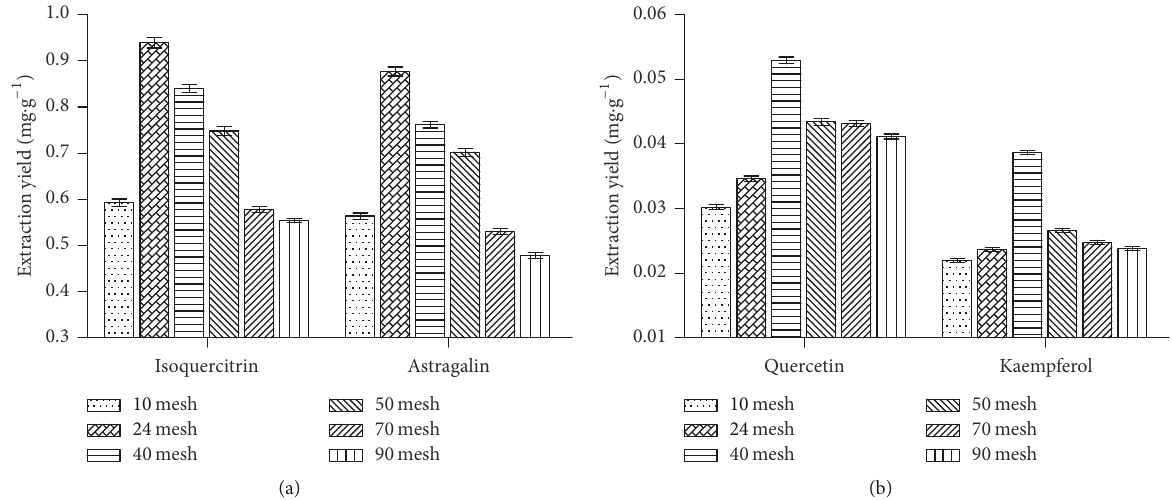
Figure 5: Effect of the particle size on extraction yields. Type of IL: [BMIM]BF 4 ; concentration: 0.5 mol ⋅ L −1 ; solid-liquid ratio: 1: 10g ⋅ mL −1 ; ultrasound time: 30 min; ultrasound power: 500 W; centrifugation speed: 5000 r ⋅ min −1